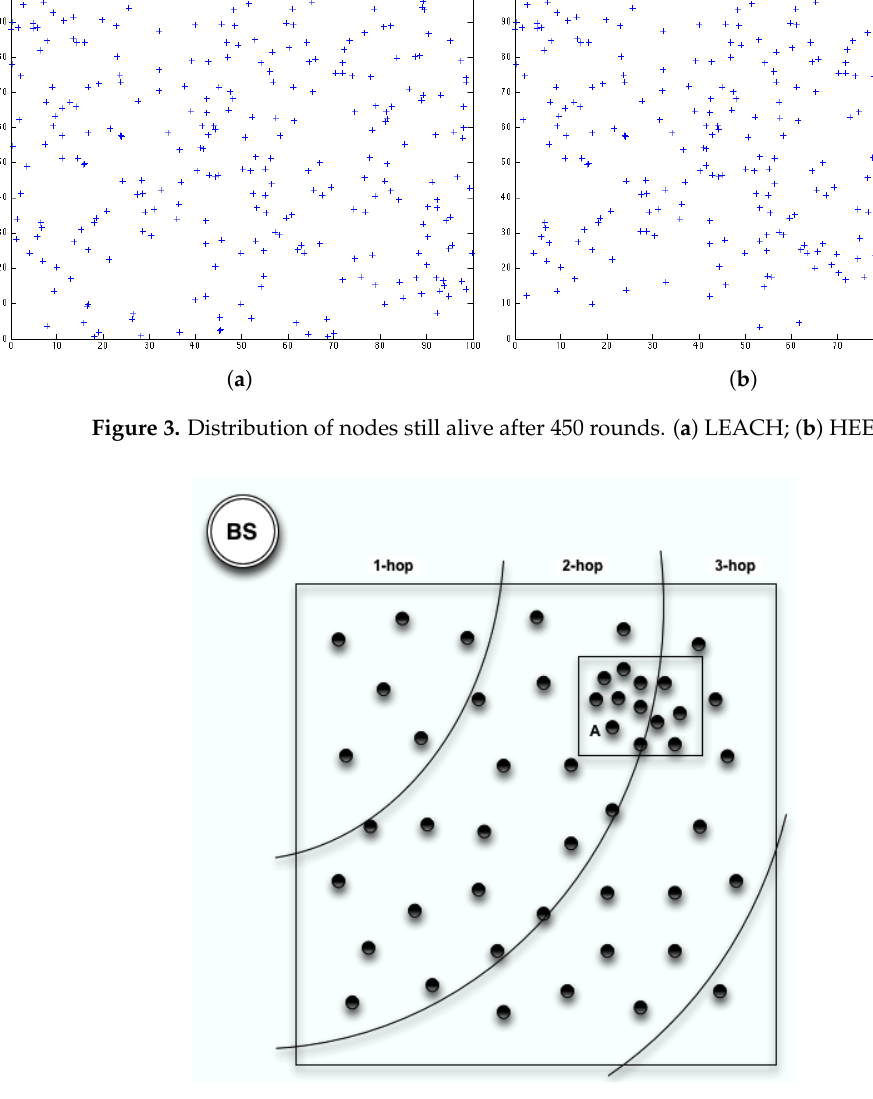
Figure 4. Non-uniform distributed